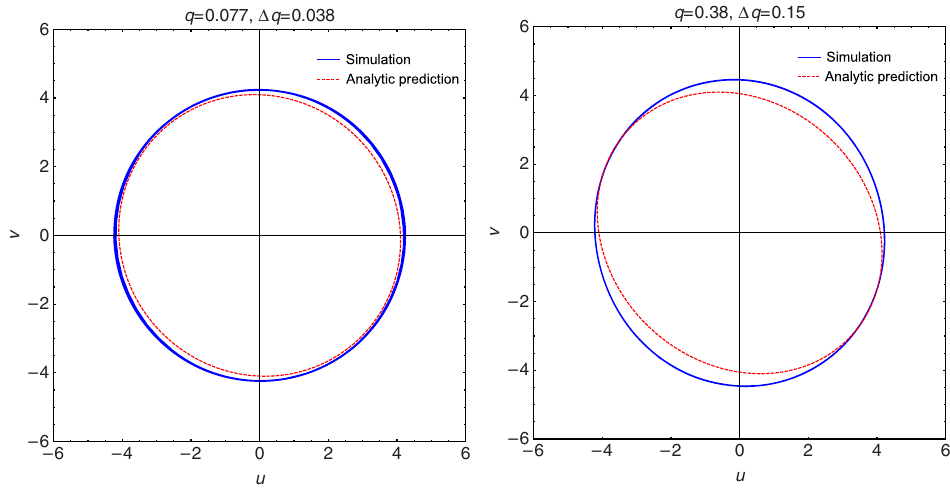
FIG. 8. Ellipse path formed under drives at unequal